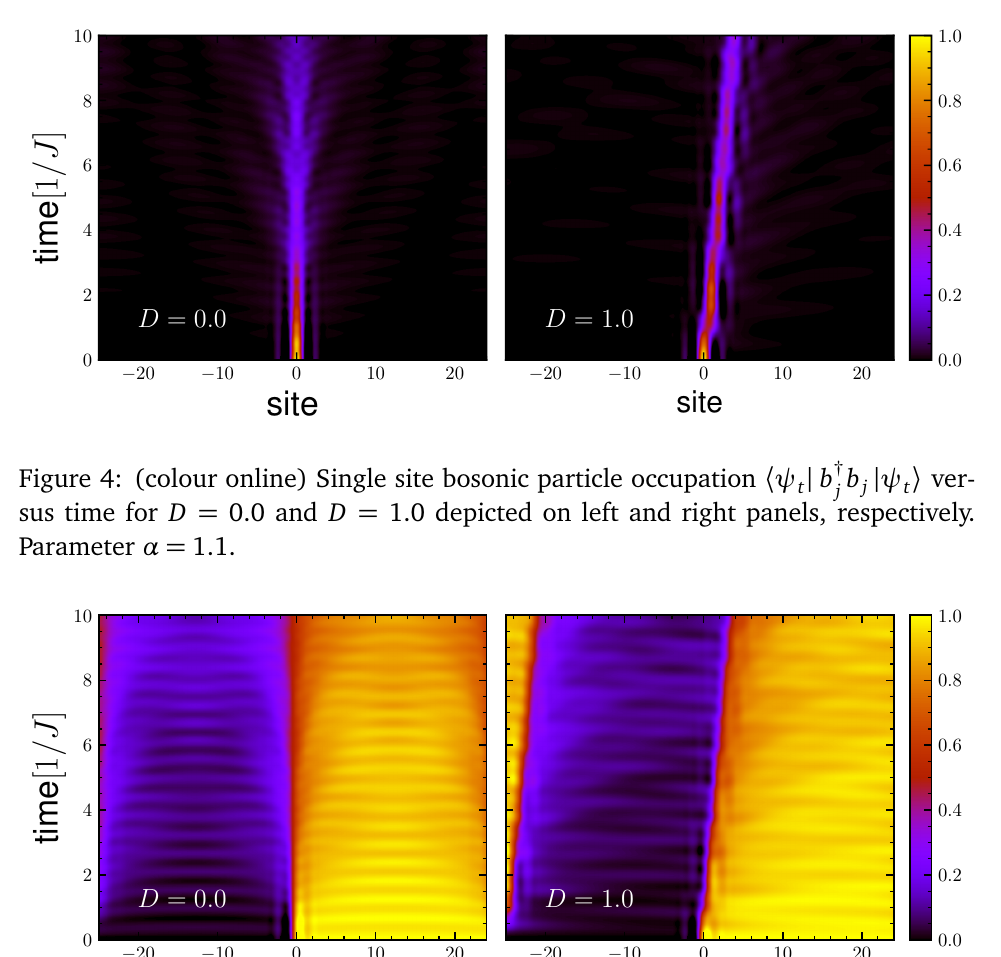
Figure 5: (colour online) Same as Fig. 4, but for a domain-wall state as spread over 〉 = c † ··· c † | 0 〉 x > 0 as | ψ 0 L L / 2